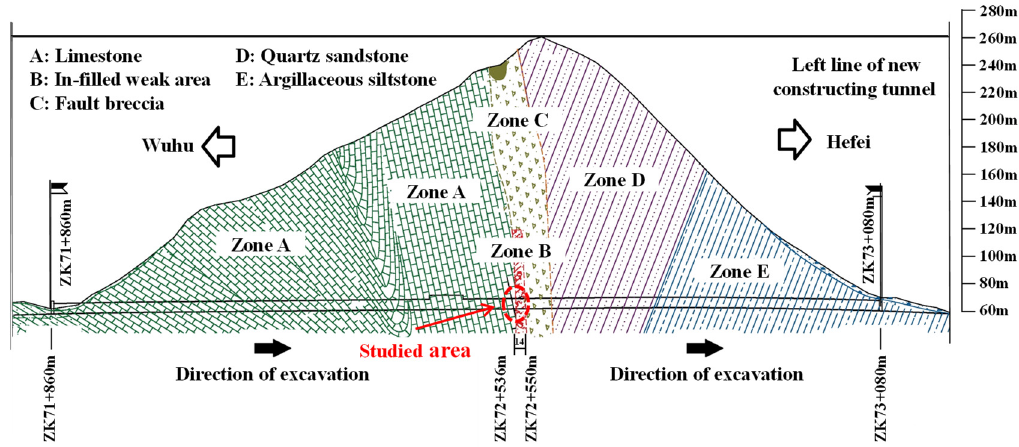
Figure 2. Longitudinal section schematic of Shidao tunnels.